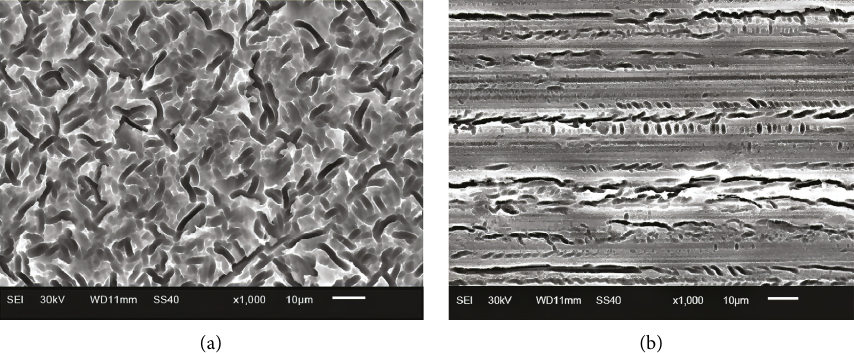
Figure 2: Surface SEM images of (a) SWS- and (b) DWS-processed mc-Si wafer after etching with additive-free conventional etching solution (HF :HNO 3 : H 2 O � 1: 5.1 :2.6, v : v : v